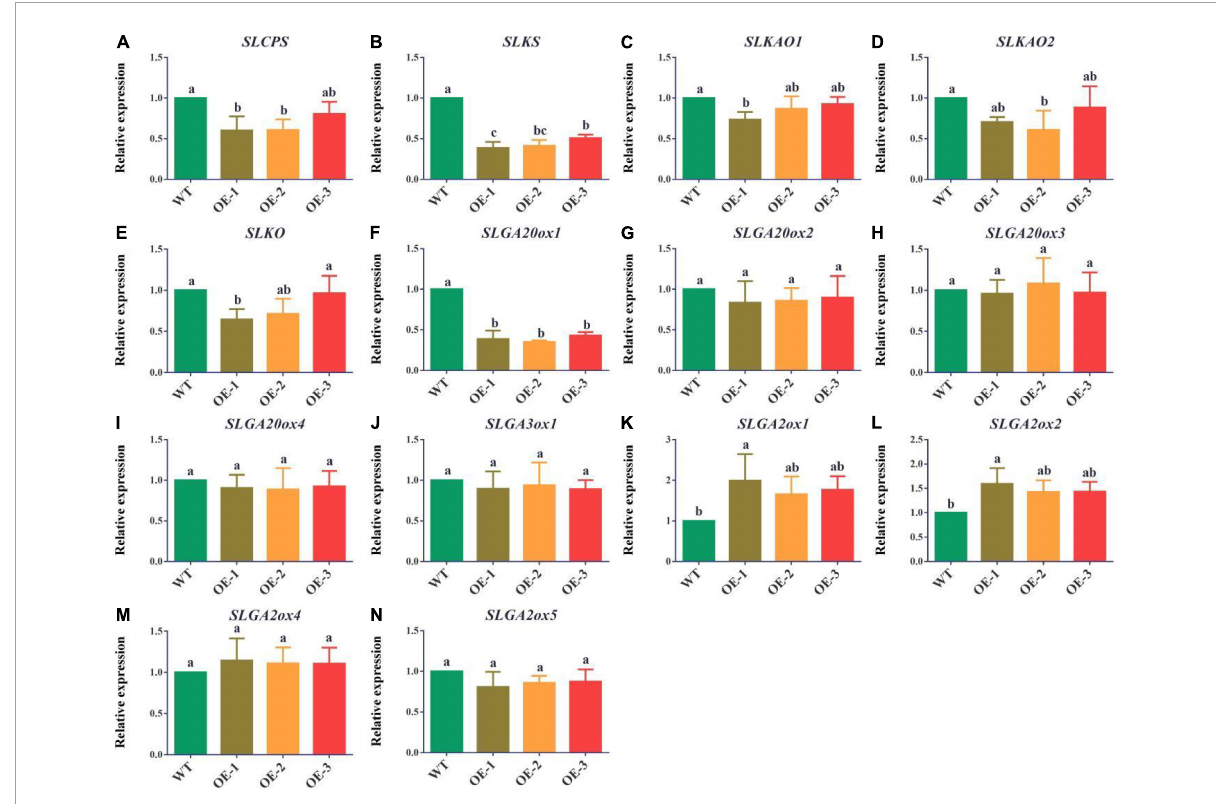
FIGURE5 Expression of GA biosynthesis genes and GA deactivated genes in PpMYB52 -overexpressing transgenic tomato and Micro Tom wild-type tomato. (A) Expression of SLCPS . (B) Expression of SLKS . (C) Expression of SLKAO1 . (D) Expression of SLKAO2 . (E) Expression of SLKO . (F) Expression of SLGA20ox1 . (G) Expression of SLGA20ox2 . (H) Expression of SLGA20ox3 . (I) Expression of SLGA20ox4 . (J) Expression of SLGA3ox1 . (K) Expression of SLGA2ox1 . (L) Expression of SLGA2ox2 . (M) Expression of SLGA2ox4 . (N) Expression of SLGA2ox5 . The values represent the means ± SD of three replicates, and the different letters above the bars represent significant differences; P <